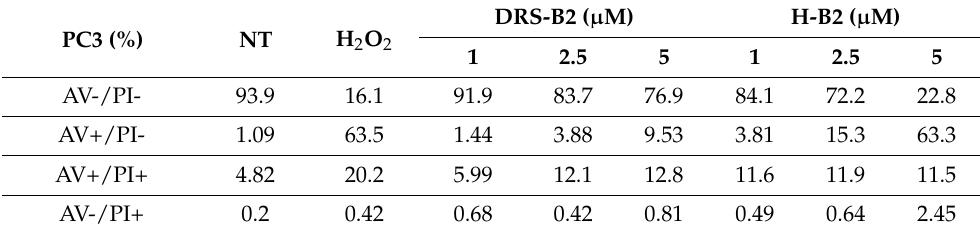
Table 3. Percentage of PC3 cells in each population extracted from Figure